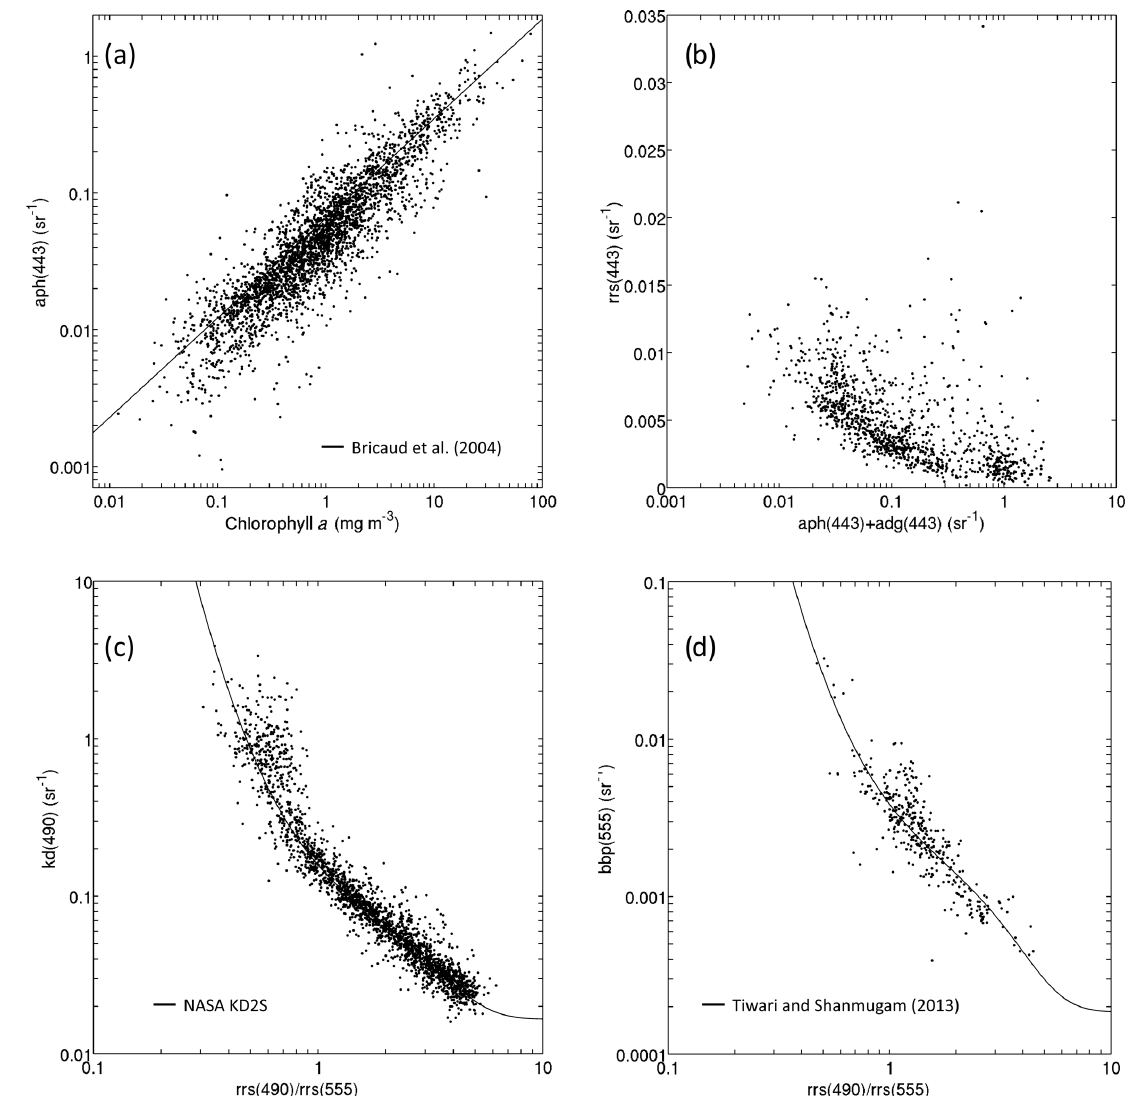
Figure 16. Examples of bio-optical relationships in the final merged table: (a) aph(443) versus chlorophyll a . The total number of points (2953) is divided between AWI (334), COASTCOLOUR (335), MERMAID (214), NOMAD (991), SeaBASS (124) and TPSS (955). For reference the solid line shows the regression from Bricaud et al. (2004). (b) [aph(443) + adg(443)] versus rrs(443). The total number of points (1112) is divided between MERMAID (33) and NOMAD (1079). (c) [rrs(490) / rrs(555)] versus kd(490). The total number of points (2280) is divided between MERMAID (62), NOMAD (2117) and SeaBASS (101). For reference the solid line shows the NASA KD2S standard algorithm (https://oceancolor.gsfc.nasa.gov/atbd/kd_490/, last access: 10 July 2019). (d) [rrs(490) / rrs(555)] versus bbp(555). The total number of points (365) is divided between MERMAID (33), NOMAD (324), and COASTCOLOUR + SeaBASS (4). For reference the solid line shows the relation proposed by Tiwari and Shanmugam (2013). A search window of 2nm was used for panels (a) and (b) , and a search window of 5nm was used for panels (c) and (d) to include data at 560nm when not available at